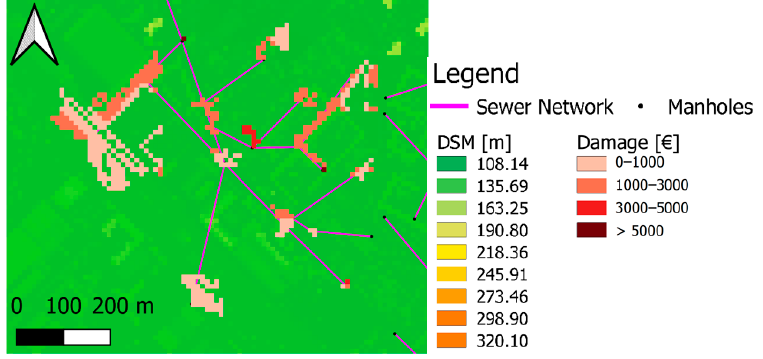
Figure 7. Final raster for damages for a design storm event with a 50-year return period in GAMA.